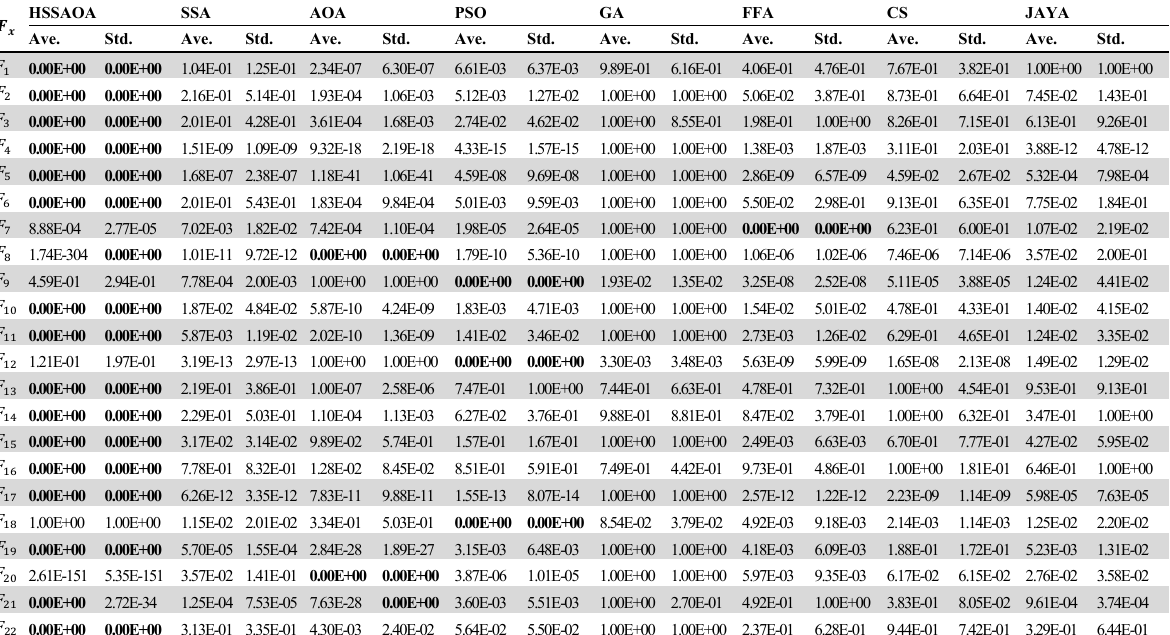
When Table 4 is examined, according to Table 3, HSSAOA, AOA and PSO algorithms have created a statistically significant difference compared to other algorithms with which they were statistically compared in benchmark functions they were successful. Table 5 contains the average and standard deviation results of the optimized benchmark functions according to Group 2. Normalized (0-1) average (Ave.) and standard deviation (Std.) results of optimized benchmark functions according to Group 2 HSSAOA SSA AOA PSO GA FFA CS JAYA 𝑭 𝒙 Ave. Std. Ave. Std. Ave. Std. Ave. Std. Ave. Std. Ave. Std. Ave. Std. Ave.